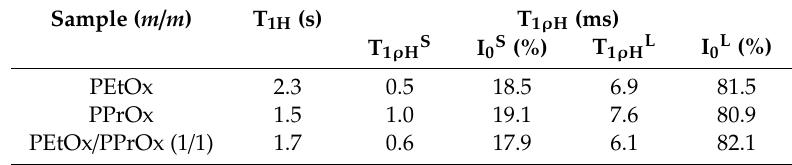
Table 1. Spin lattice relaxation times recorded in a lab frame (T 1 ) and the rotating frame (T 1 ρ ) of spray dried PEtOx, PPrOx and a 1-1 ( m / m ) combination of both polymers. In the rotating frame, a short (S) and long (L) relaxation time was detected for all three samples. I 0 gives the percentages of both relaxation times.